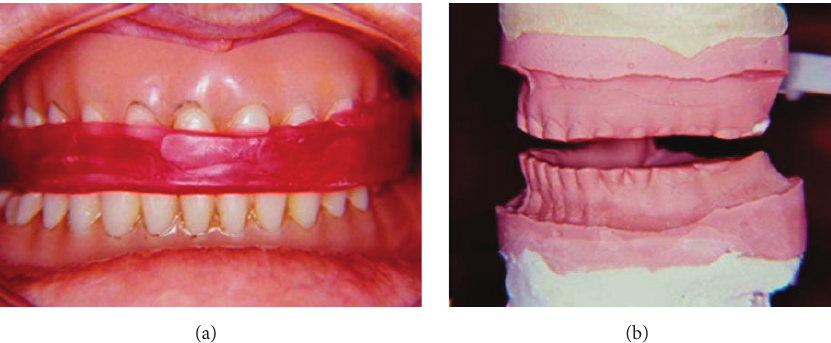
Figure 1: Record for reestablishment of 7 mm in the OVD. (a) Record in wax with 7 mm; (b) first master cast set mounted in a semiadjustable